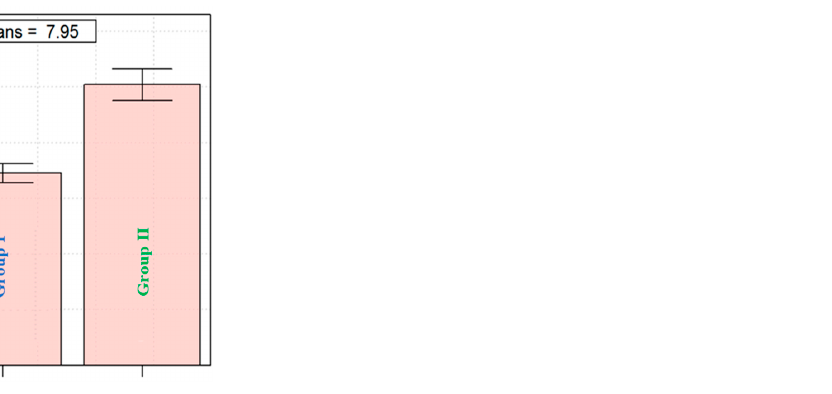
Figure 3. Statistical comparison of mean shear bond strength (SBS) of Group I and Group II with standard error (SD = ±2.5).